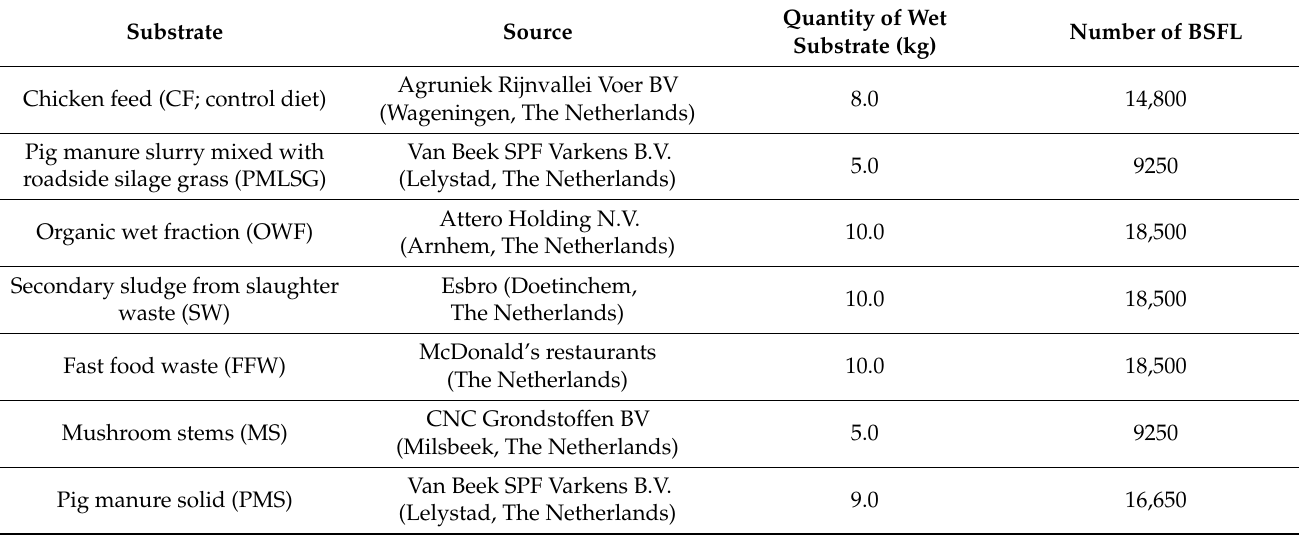
Table 1. An overview of the source of each substrate, the quantity of the wet substrate (kg) and the number of larvae at the beginning of the trial in each repetition (container) across the treatments. Quantity of Wet Number of Substrate Source Substrate (kg)